Question: Give a one-sentence summary of this figure.
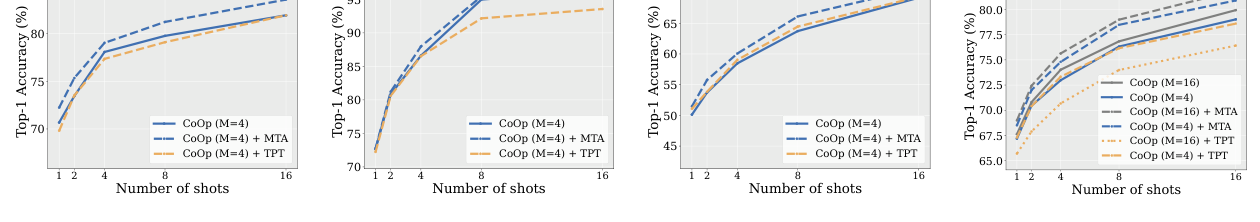
Answer: Few-shot learning results on the 10 fine-grained datasets and ImageNet. We compare MTA and TPT when added on top of CoOp prompts (M=4 tokens) for increasing number of shots. Averaged top-1 accuracy over the 11 datasets is shown on the bottom right, we additionally show the averaged top-1 accuracy for CoOp with M=16 tokens.